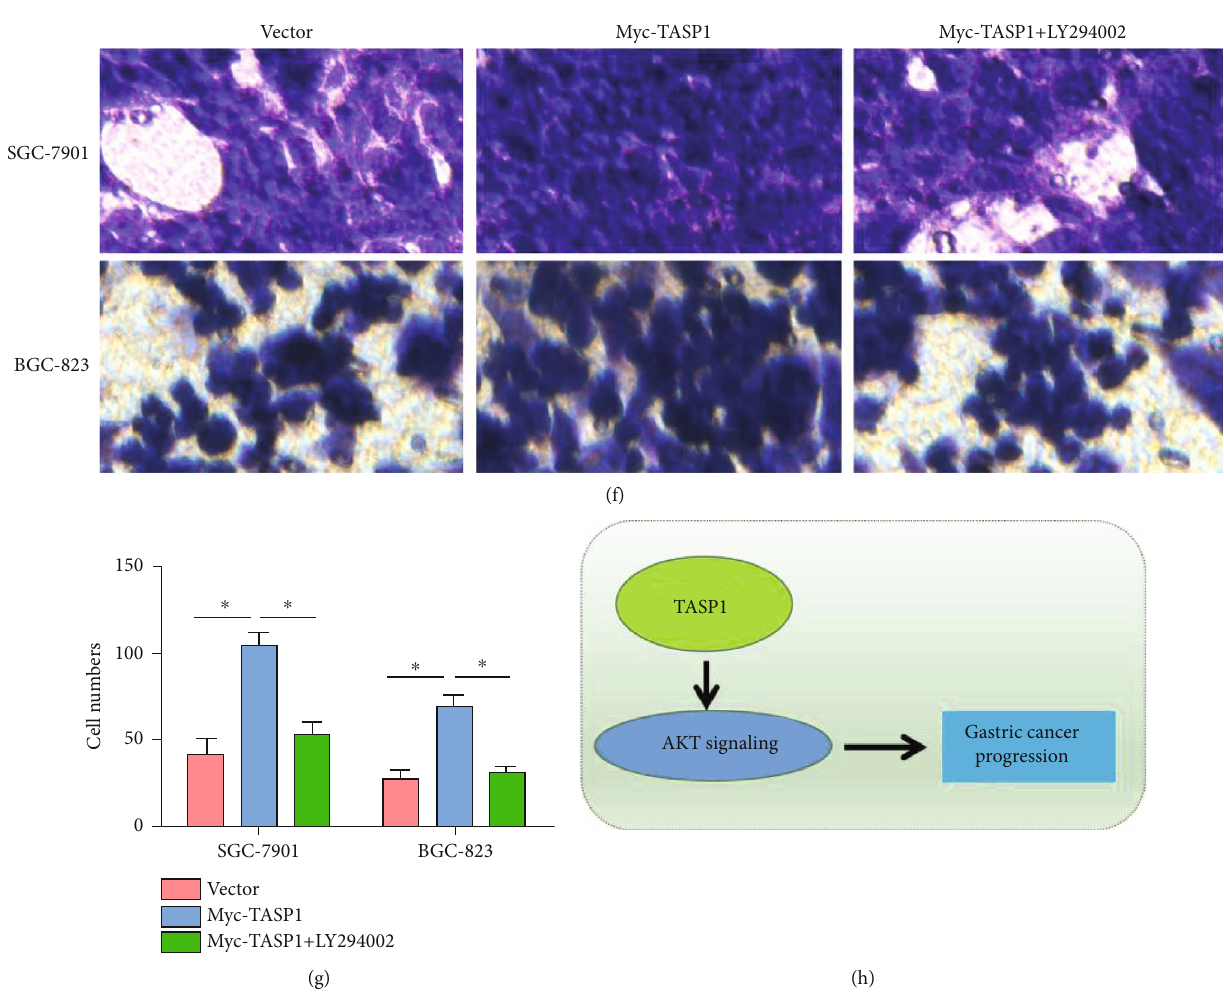
Figure 5: TASP1 promotes GC progression via the p-AKT/AKT signaling pathway. (a) The TASP1, AKT, and p-AKT protein expressions in Myc-TASP1-transfected GC cells that treated with LY294002. (b, c) The relative TASP1 and p-AKT/AKT protein expressions in Myc- TASP1-transfected GC cells that treated with LY294002. (d, e) The proliferation abilities of cells in Myc-TASP1-transfected GC cells that treated with LY294002. (f, g) The migration abilities of cells in Myc-TASP1-transfected GC cells that treated with LY294002. (h) The proposed mechanistic scheme of TASP1 regulating GC progression via AKT